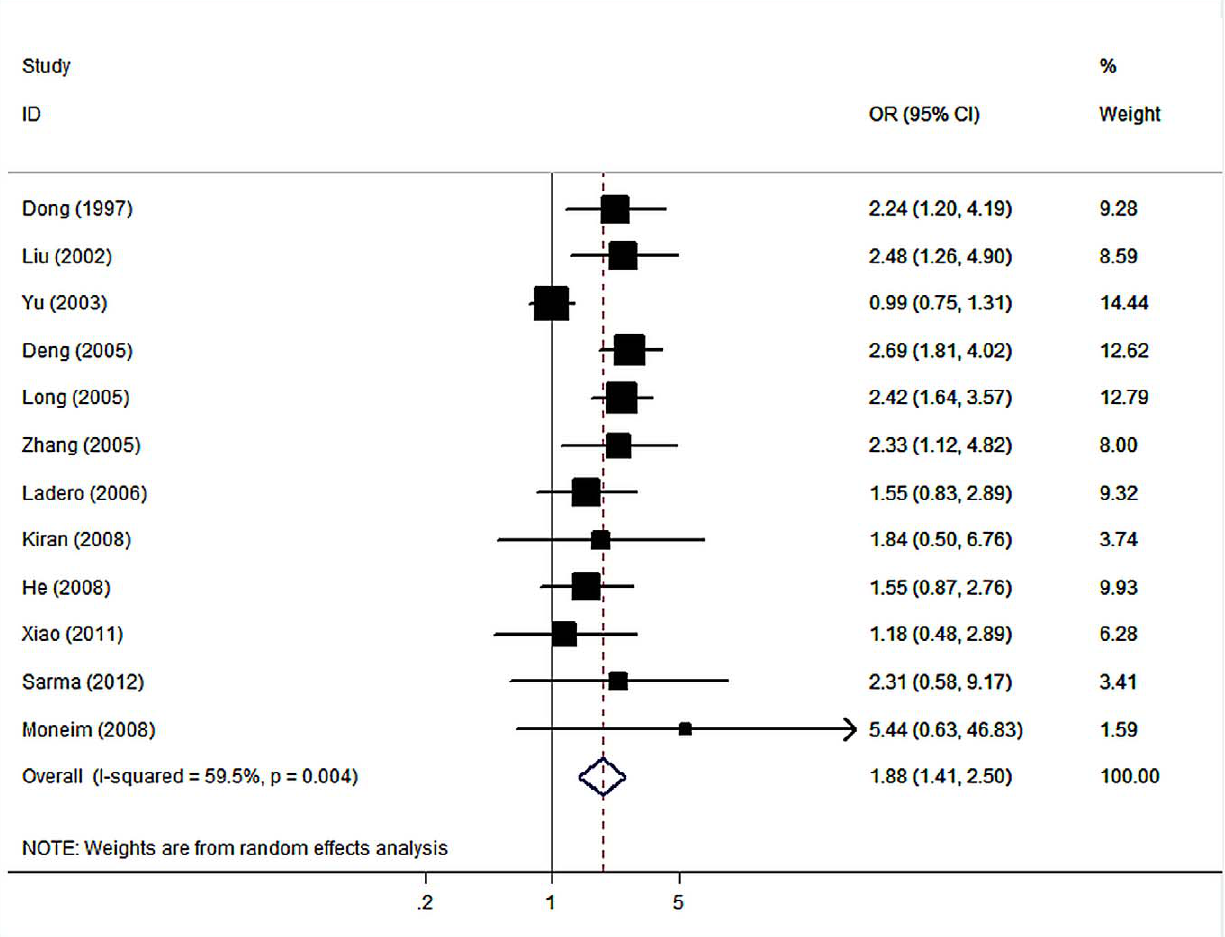
Figure S1 Flow diagram of the study selection process. Figure S2 Begg’s funnel plot for publication bias in selection of studies on GSTM1 polymorphism.